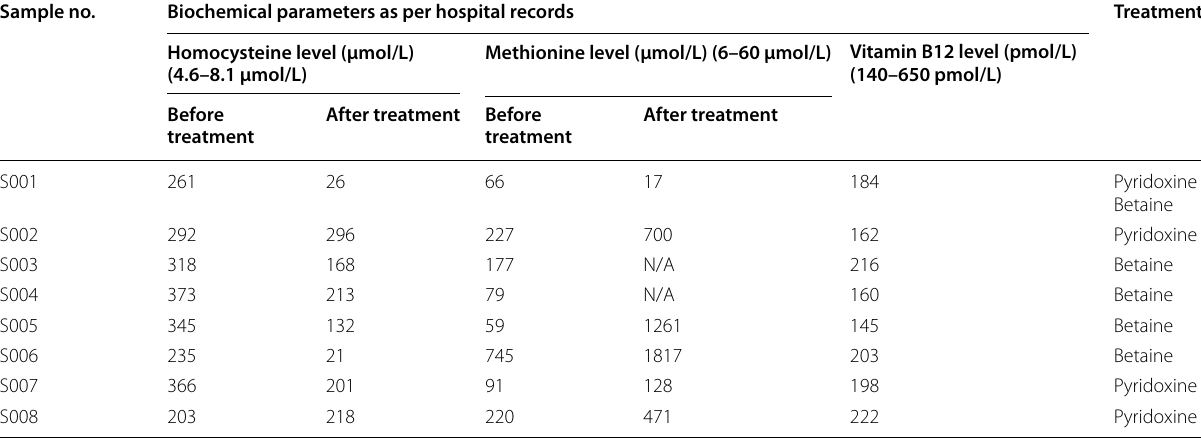
Table 2 Comparison of homocysteine, methionine and vitamin B12 levels of the patients before and after the treatments Sample